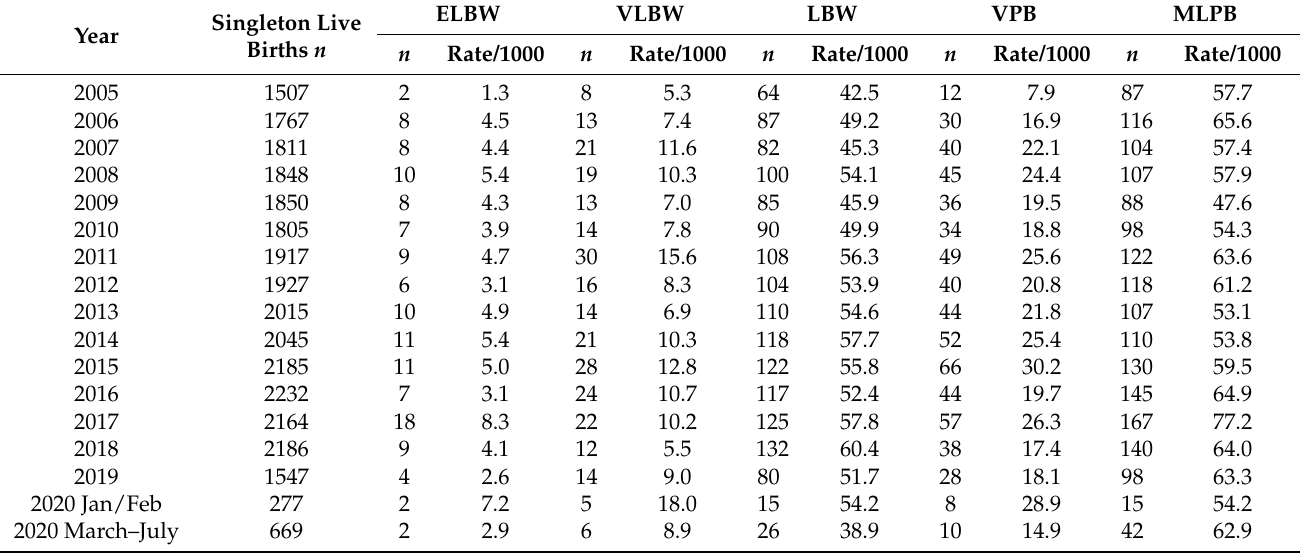
Table 1. Rates of ELBW (<1000 g), VLBW (<1500 g), LBW (1500–2500 g), VPB (<32 weeks), MLPB (32–36 week) at the Danube Hospital between 2005 and